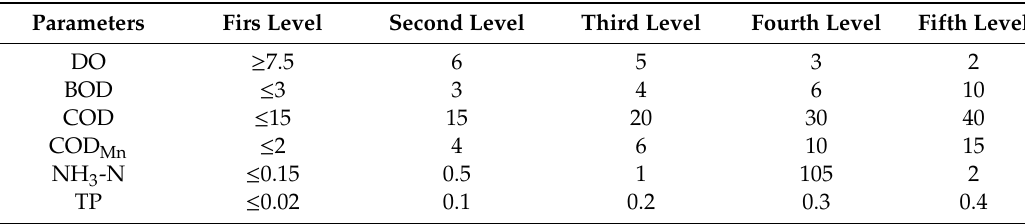
Table 3. National quality standards for surface waters in China